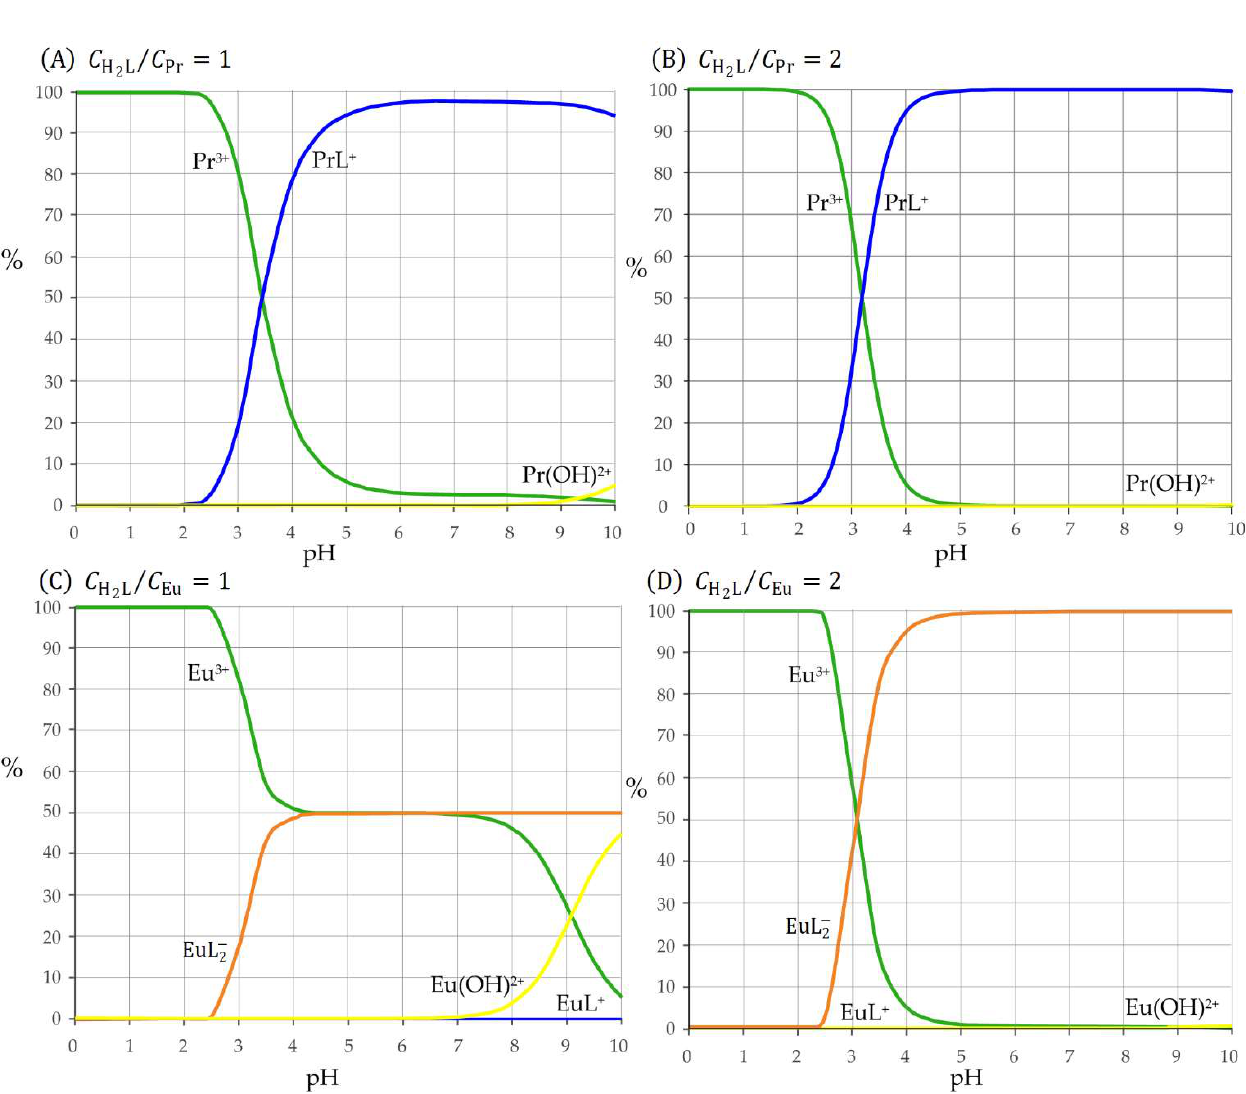
Figure 6B. With minor variations due to changes in the value of the 𝛽 (cid:2869)(cid:2869)(cid:2868) formation con-